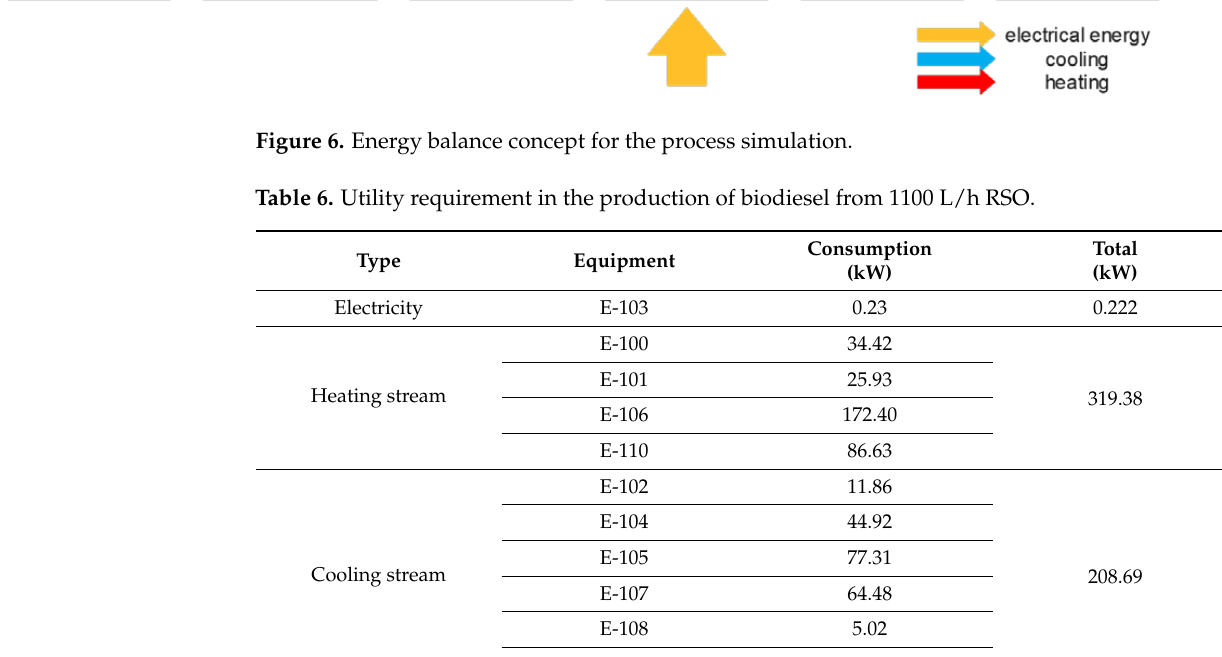
Table 6. Utility requirement in the production of biodiesel from 1100 L/h RSO.